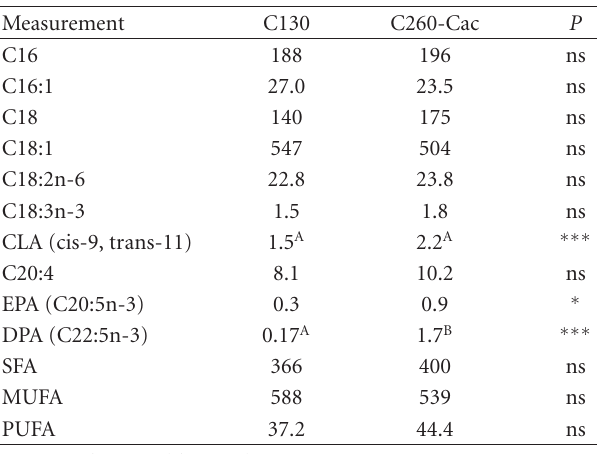
Table 3: Average fatty acid (FA) profile in meat fat of kids, g/kg.